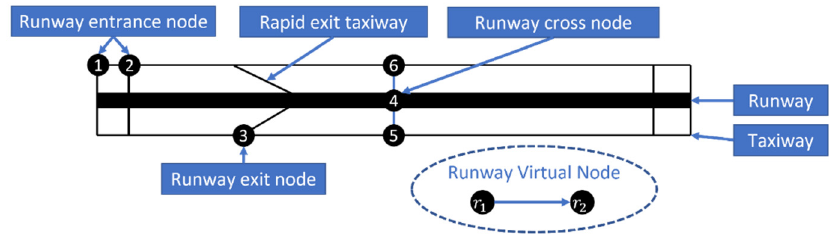
Figure 5. Runway virtual nodes and cross nodes.